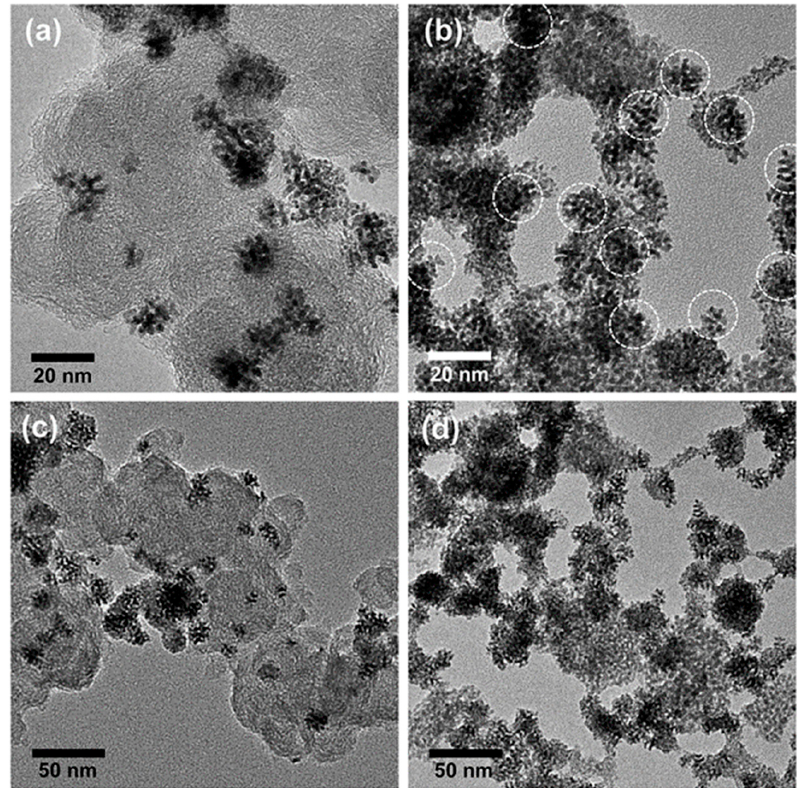
Figure 14. HR-TEM images of Ir-nanodendrite supported on ( a ) carbon black and ( b ) antimony-doped tin oxide. Low magnification TEM images of ( c ) Ir-nanodendrite/carbon and ( d ) Ir-nanodendrite/antimony-doped tin oxide. Reproduced from Ref. [20] with permission from the Royal Society of Chemistry, 2015.